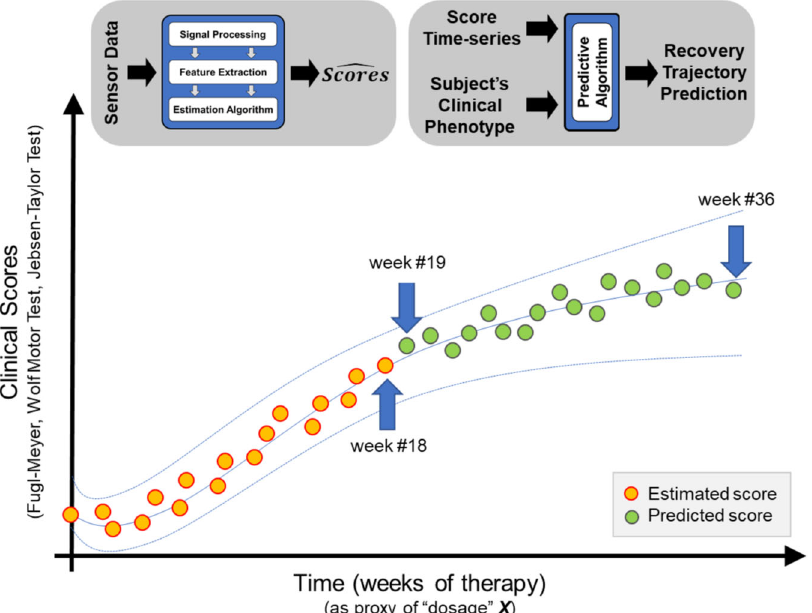
Fig. 4 Monitoring the motor recovery trajectory using wearable sensors. The time series represent the recovery trajectory of a hypothetical subject undergoing rehabilitation. Clinical scores estimated via the analysis of wearable sensor data (orange circles) provide measures of arm ability across domains of the ICF. Predicted scores (green circles) derived using a model based on the time series of estimated clinical scores (orange circles) and subject ’ s clinical phenotype provide estimates of the anticipated response to the intervention. A fi tting function (e.g., a polynomial equation) represents the recovery trajectory. Con fi dence intervals are provided for the estimated and predicted